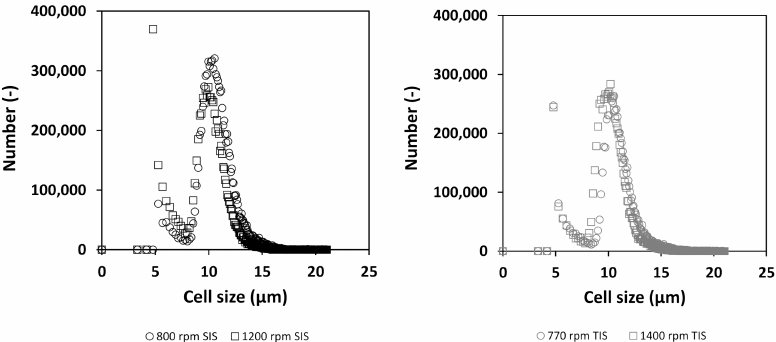
Figure A3. Exemplary cell size distributions from cultivation data in the SIS (800 rpm and 1200 rpm) and in the TIS (770 rpm and 1400 rpm). Distributions for all cultivations were taken from samples at 72 h cultivation